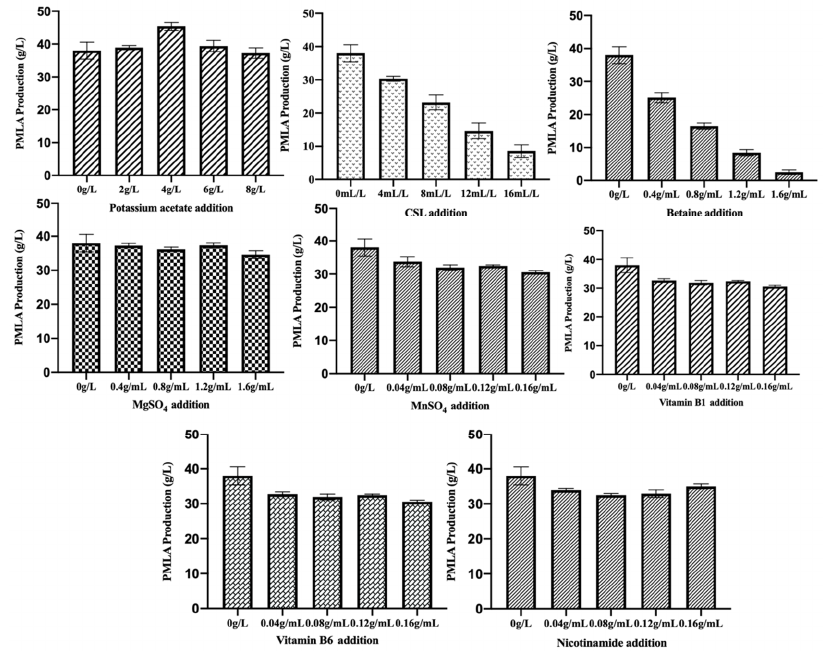
Figure 1. The evaluation of single substrates addition on PMLA